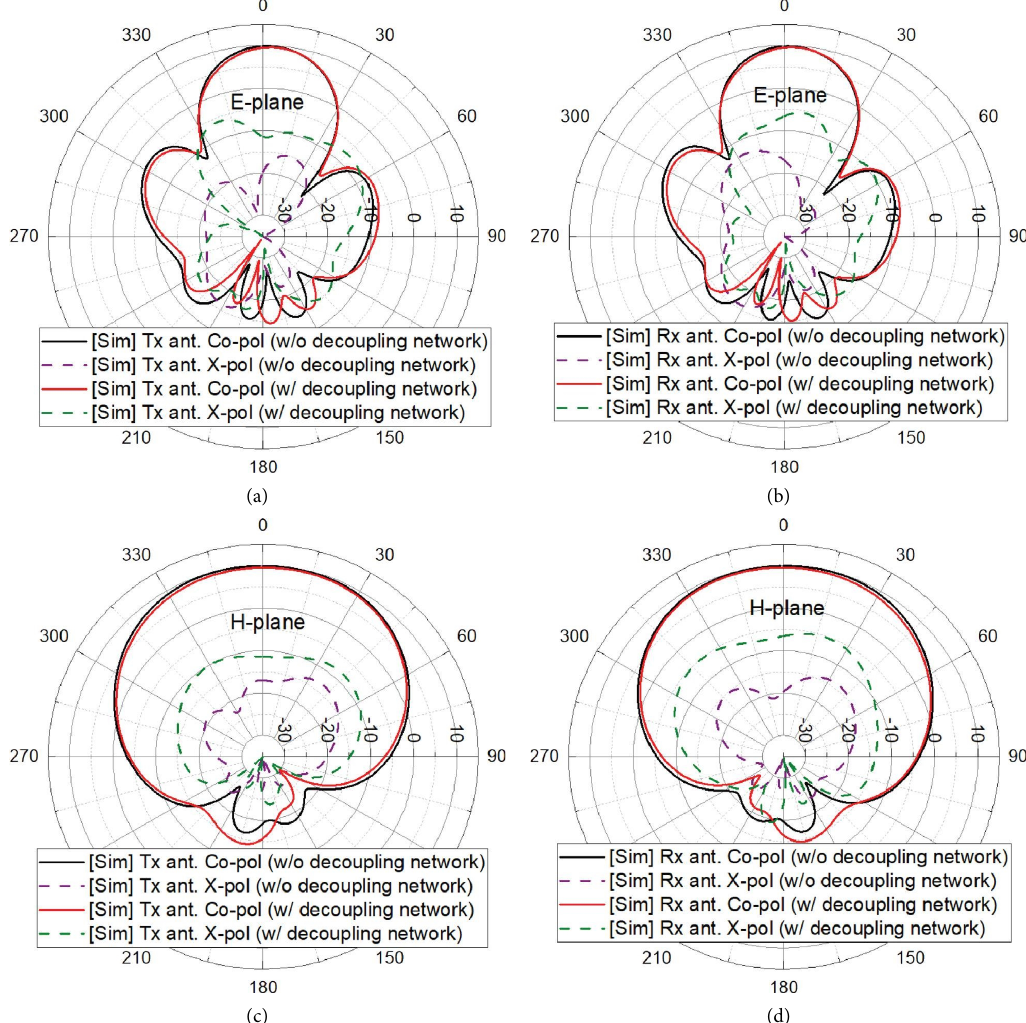
Figure 13: Simulated beam patterns of Tx/Rx antennas without and with the decoupling network at the frequency of 24.1 GHz: (a) E-plane of Tx antenna, (b) E-plane of Rx antenna, (c) H-plane of Tx antenna, and (d) H-plane of Rx